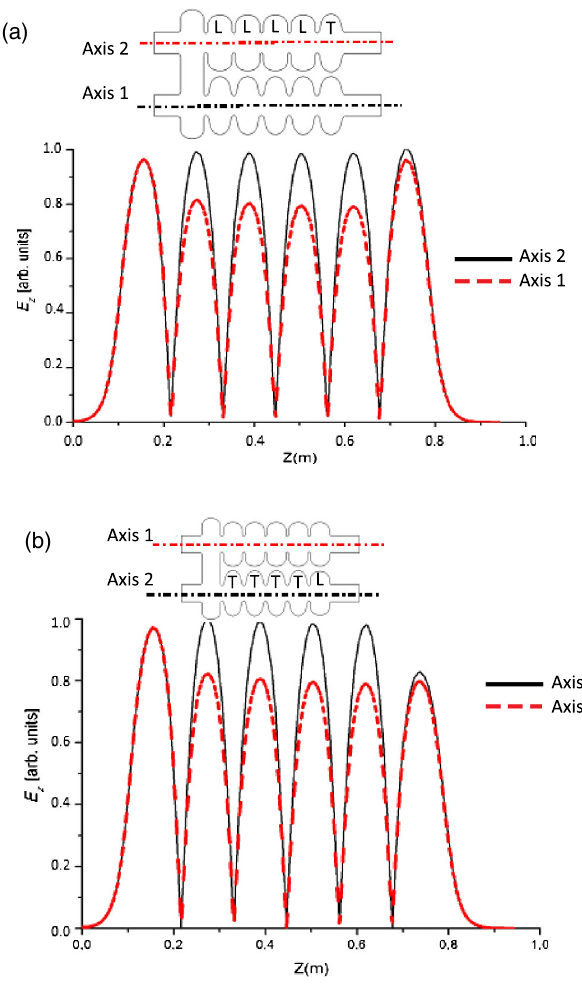
FIG. 4. (a) The dependence of the absolute value of the accelerating field ( E z ) along the longitudinal coordinate z on both axes if the dual-axis asymmetric cavity is constructed with the T (axis 2) and L þ T (axis 2) cavity cells as shown in the inset. (b) The variation of the absolute value of the accelerating field ( E z ) along the longitudinal coordinate z for both axes. This is in the case that the dual-axis asymmetric cavity is constructed with the L (axis 1) and T þ L (axis 2) cells as shown in the